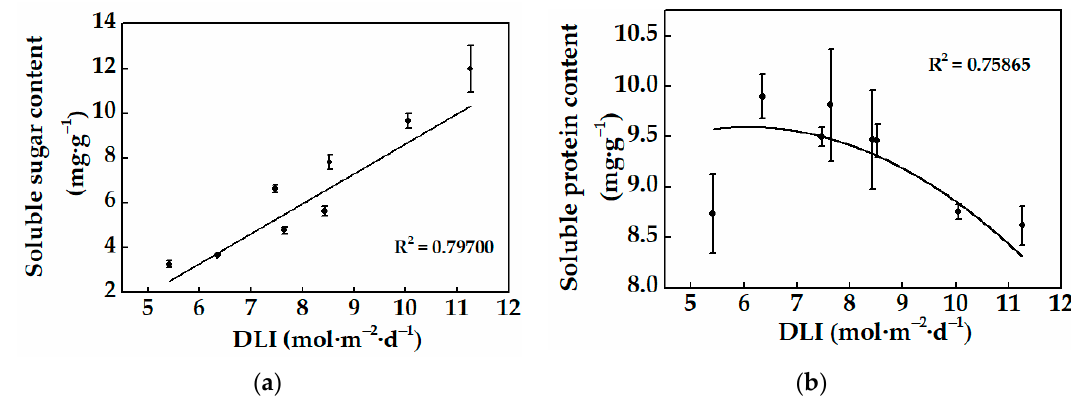
Figure 4. Relationships between DLI and ( a ) soluble sugar content and ( b ) soluble protein content of cucumber seedlings. Each symbol represents the mean of three repeats in each treatment, and error bars represent SEs of means. Fitting formula shown in supplementary section.